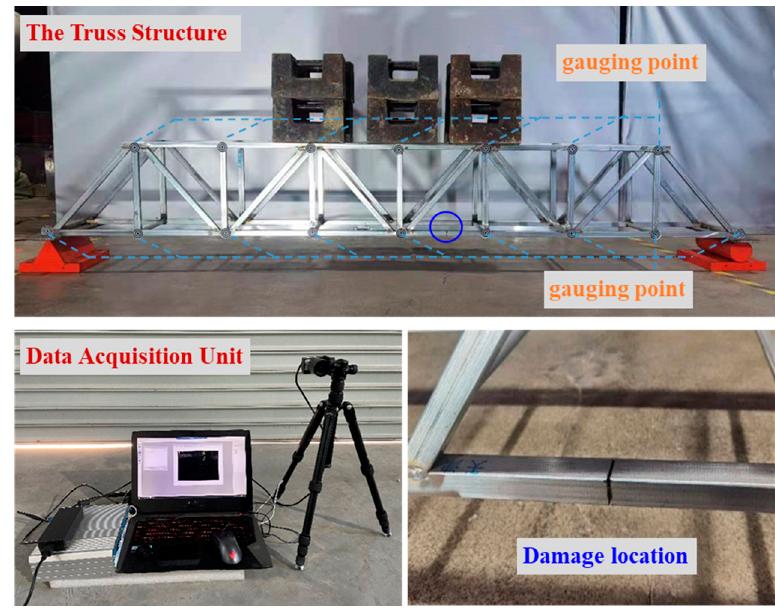
Figure 7. A steel truss structure.